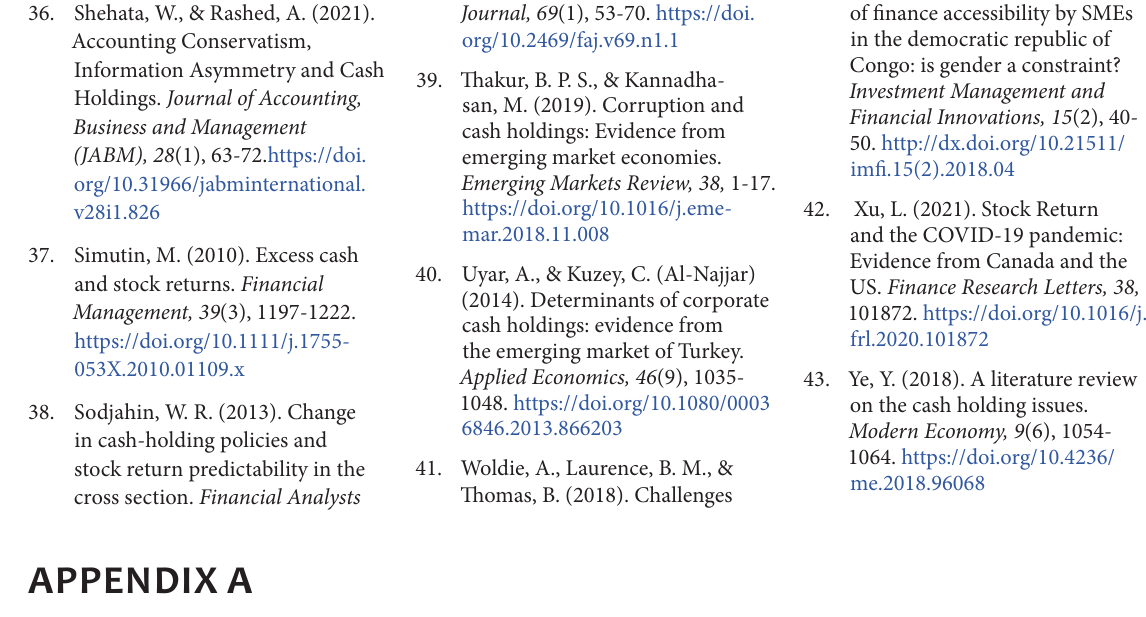
Table A1. All firms listed in the